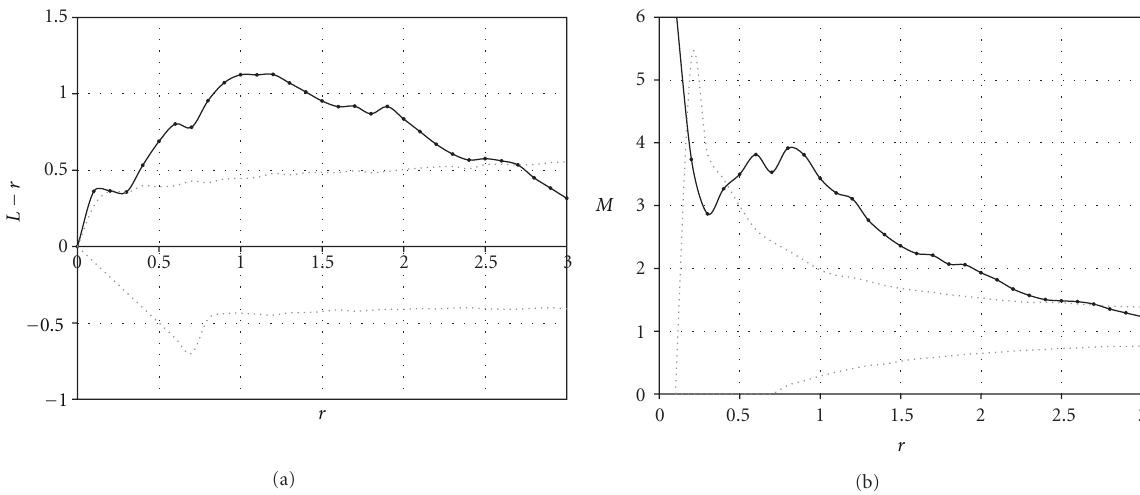
Figure 2: Aggregates, univariate L and M functions for the aggregated point set. Solid curves are the L and M function values; dotted lines are the envelope of the confidence interval of the null hypothesis. Both functions detect clumping. L ( r ) − r is plotted rather than L ( r ) for convenience.